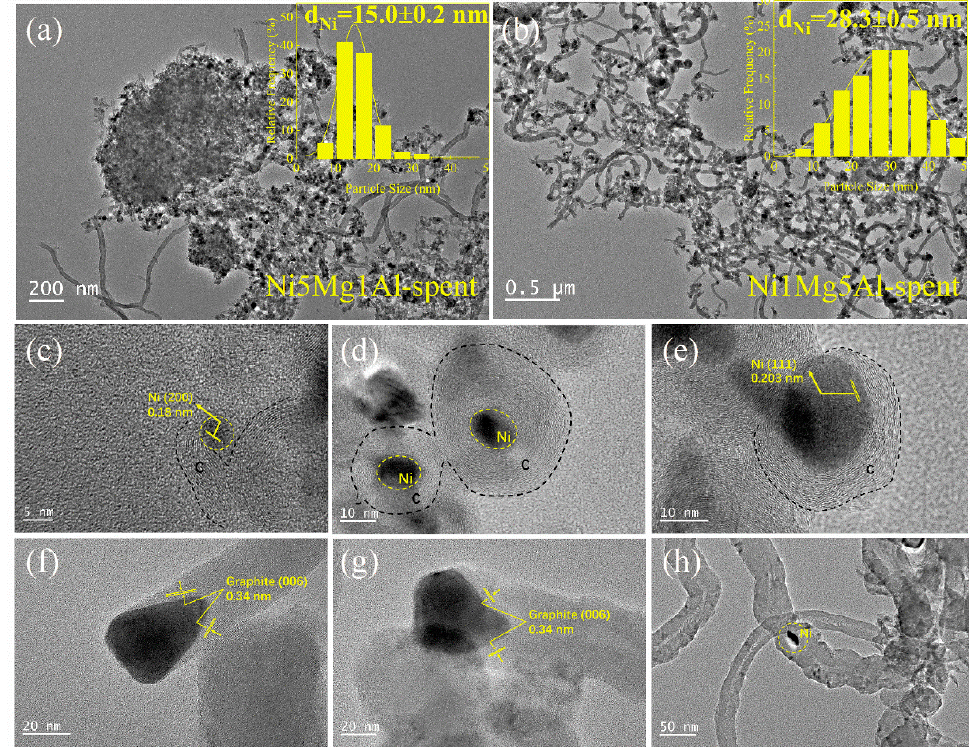
Figure 8. TEM images with the size distributions of Ni particles (inset) for ( a ) spent Ni5Mg1Al-800 catalyst and ( b ) spent Ni1Mg5Al-800 catalyst, HRTEM images for ( c – e ) spent Ni5Mg1Al-800 catalyst and ( f – h ) spent Ni1Mg5Al-800